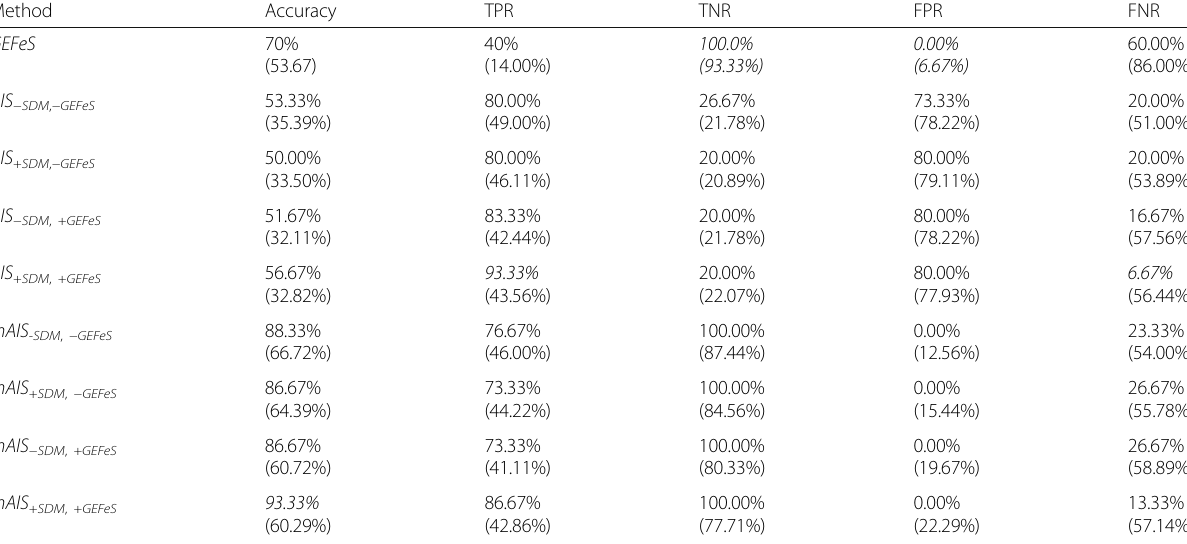
Table 2 The results of comparing the nine methods on the 30-28 dataset